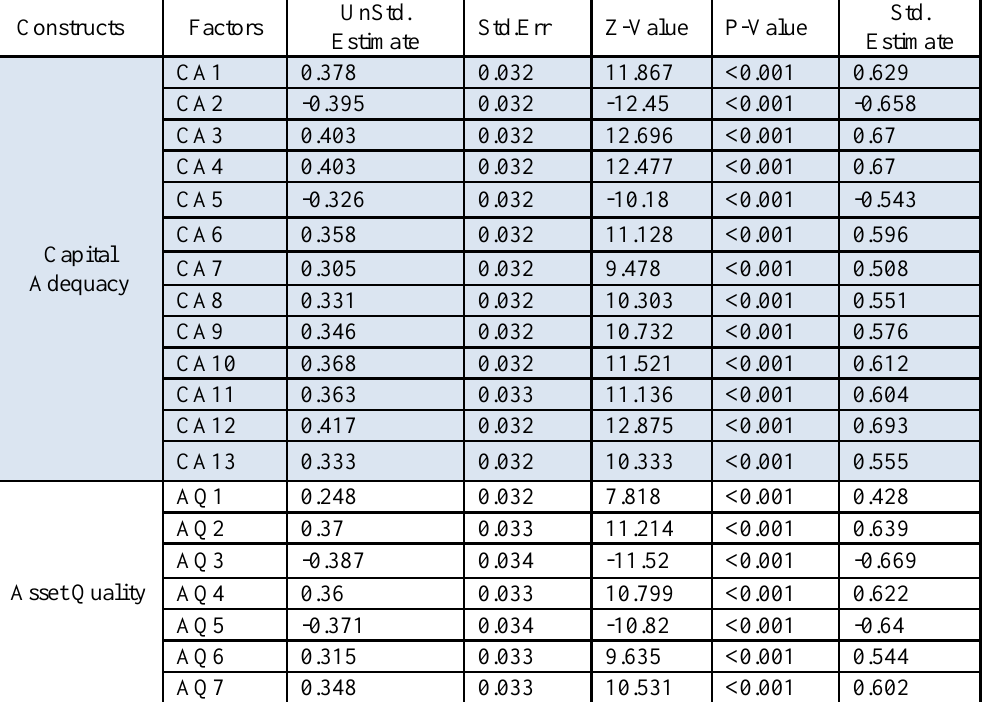
Table 4. Results of the second-order factor analysis of the modified model UnStd. Constructs Factors Std.Err Z-Value P-Value Estimate